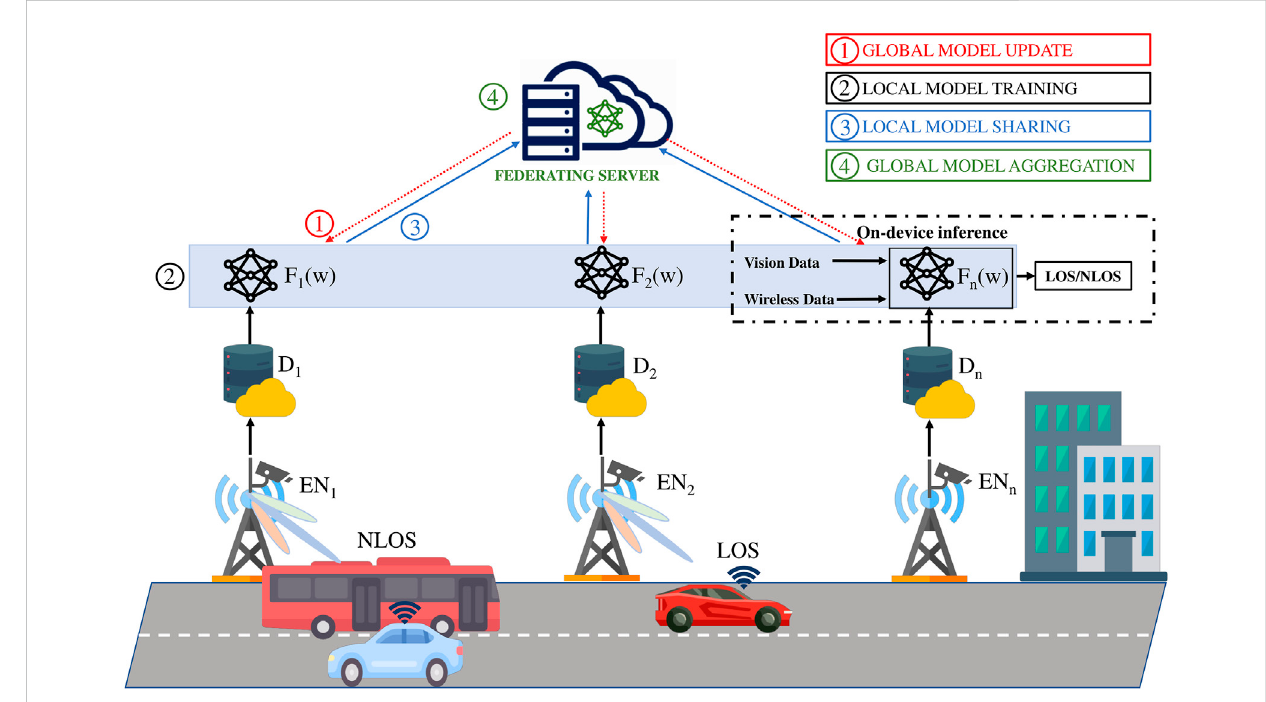
FIGURE 1 ProposedVFWNforbeamblockagepredictionforfuturewirelessnetworks.Inthissystem,weassumeeachBSactsasanedgenodes(EN)equipped with vision and wireless sensing to capture real-time data, capable of local processing and model